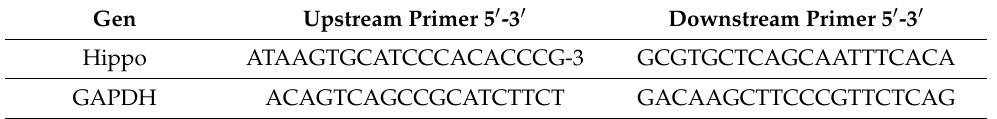
Table 1. PCR primer sequences